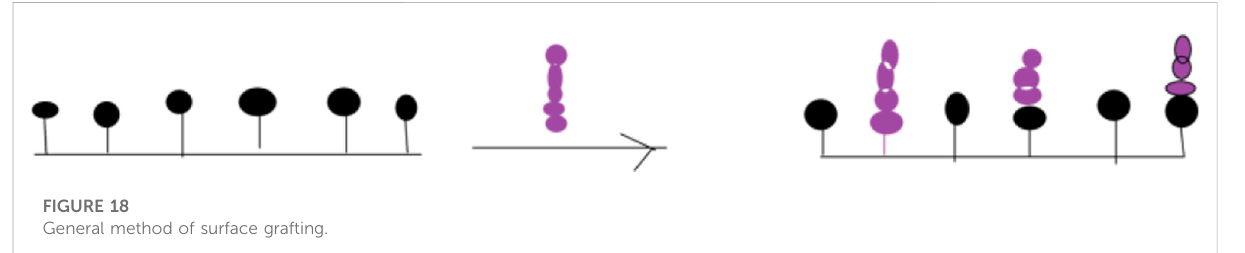
FIGURE 18 General method of surface